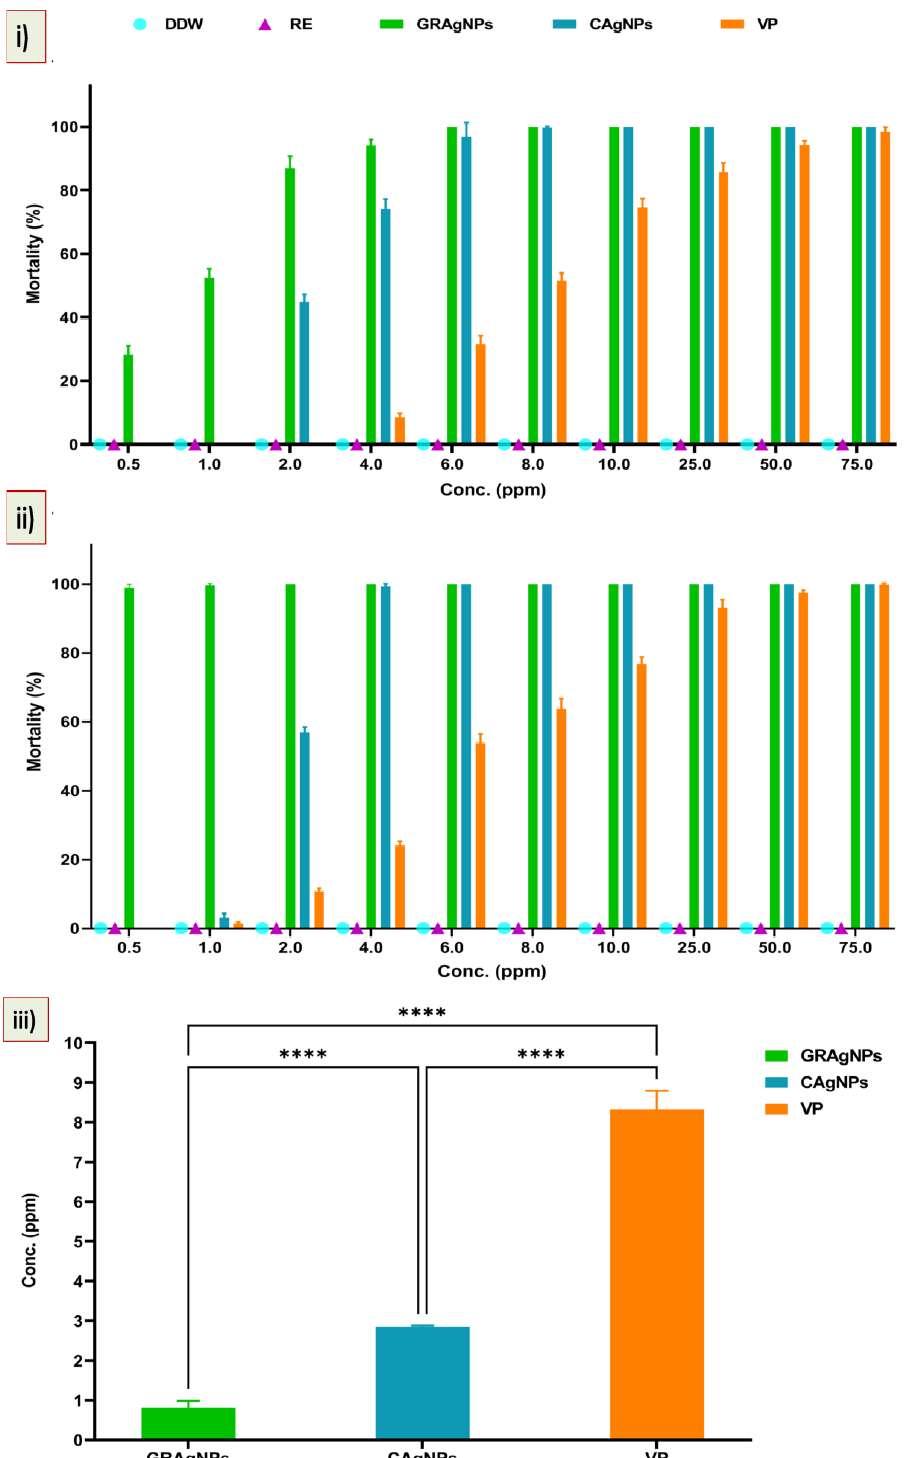
Figure 5. Mortality (%) and response of second stage juveniles (J2s) to GRAgNPs treatment. (i) % mortality after 12 h, (ii) % mortality after 24 h of treatment, (iii) Graph showing median lethal dose (LC-50) of GRAgNPs, CAgNPs, and VP calculated using one-way ANOVA with Turkey’s multiple comparisons test at 95% CI and α=0.05 (where **** = p < 0.0001). Columns are mean of 6 replicates; error bars represent the standard error. [Where, DDW = double distilled water, RE = aqueous root extract of G. glabra , GRAgNPs = silver nanoparticles synthesized using aqueous root extract of G. glabra , CAgNPs = commercial silver nanoparticles, and VP = commercial nematicide, Velum prime].